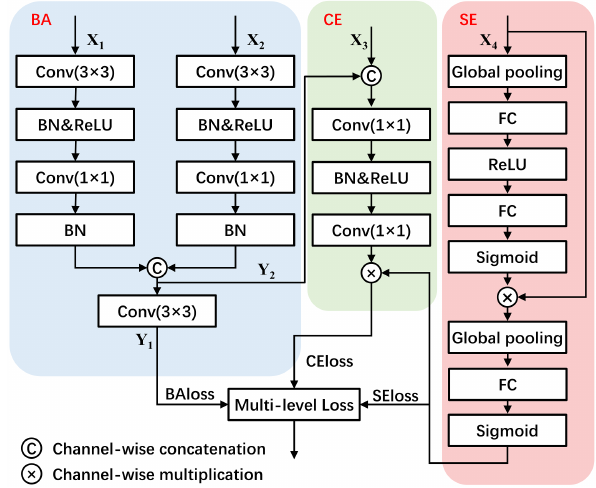
Figure 7. Framework of designed multiple loss